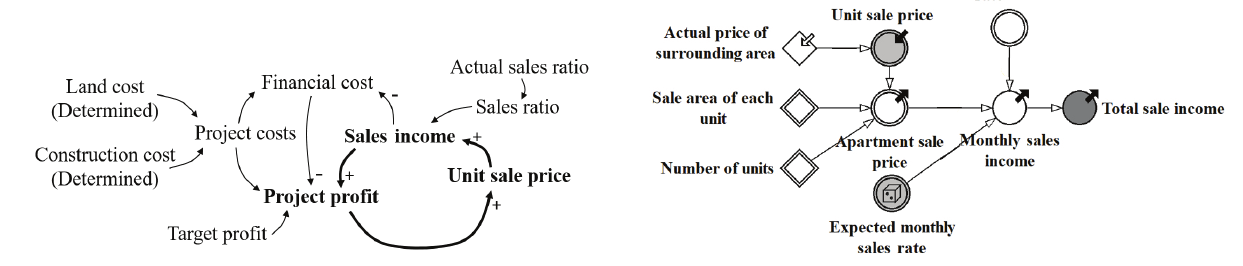
Figure 6. Causal loop diagram focused on t 3 Figure 7. Income